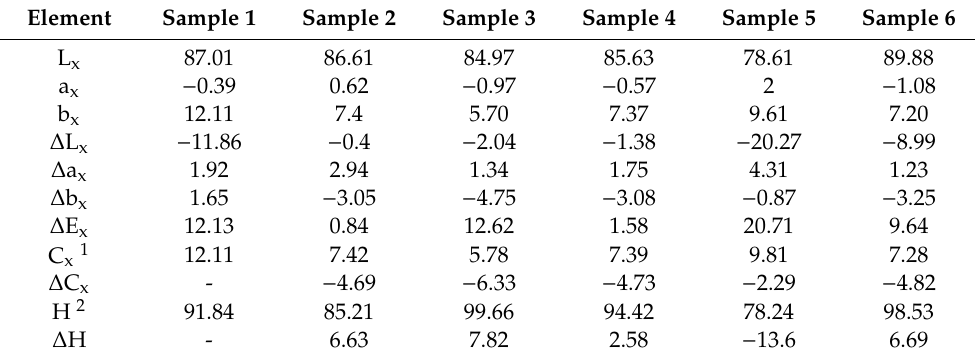
Table 5. The chromatic parameters of the mosaic